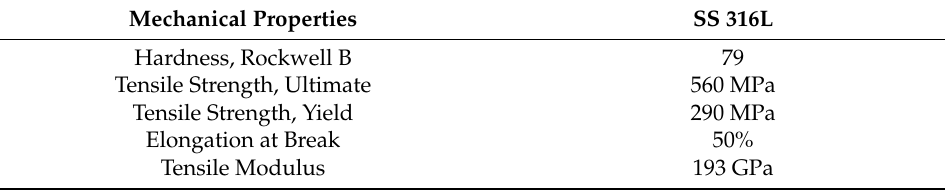
Table 2. Mechanical properties of SS 316L.